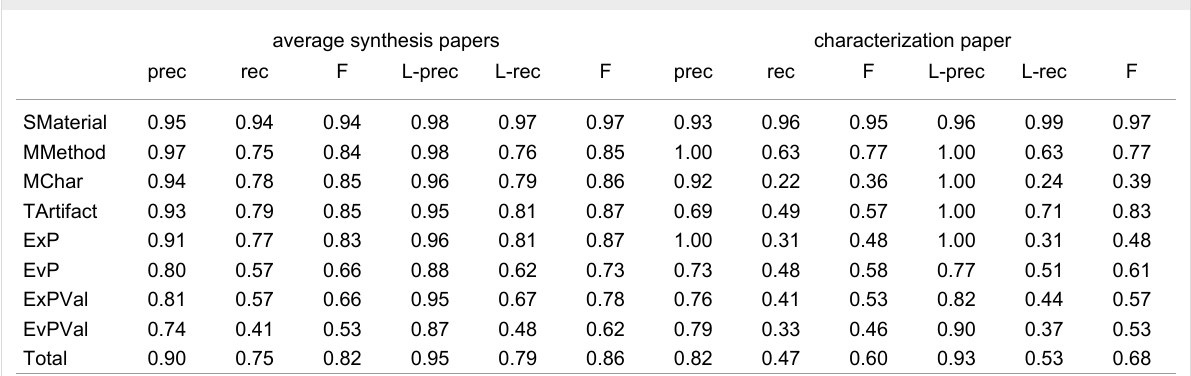
Table 4: NaDevEx average performance on synthesis and characterization papers using five-fold cross validation. a average synthesis